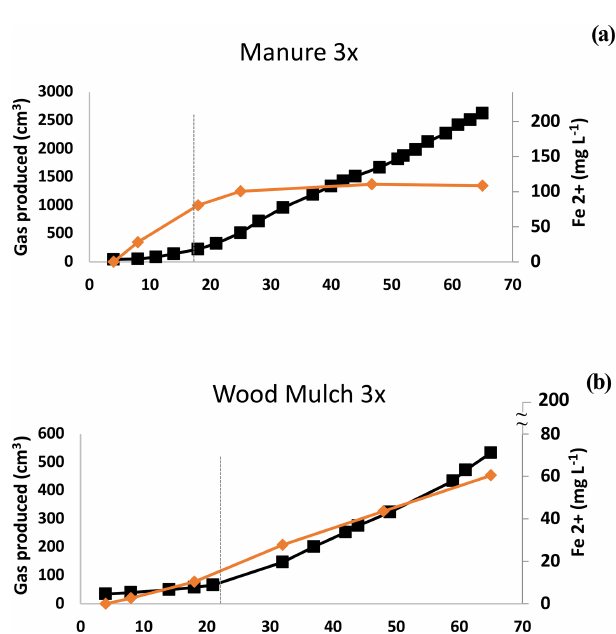
Figure 4. Experiment 1b. Ferrous iron (Fe 2 + ) and methane (CH 4 ) in selected microcosms. Depletion of Fe coincided with the break- point (dashed line) with manure but not with wood mulch. Other examples of this pattern are shown in Fig. S6. The maximum value on the secondary x axis is the maximum expected Fe 2 + concentra- tion based on the HHCL extraction.